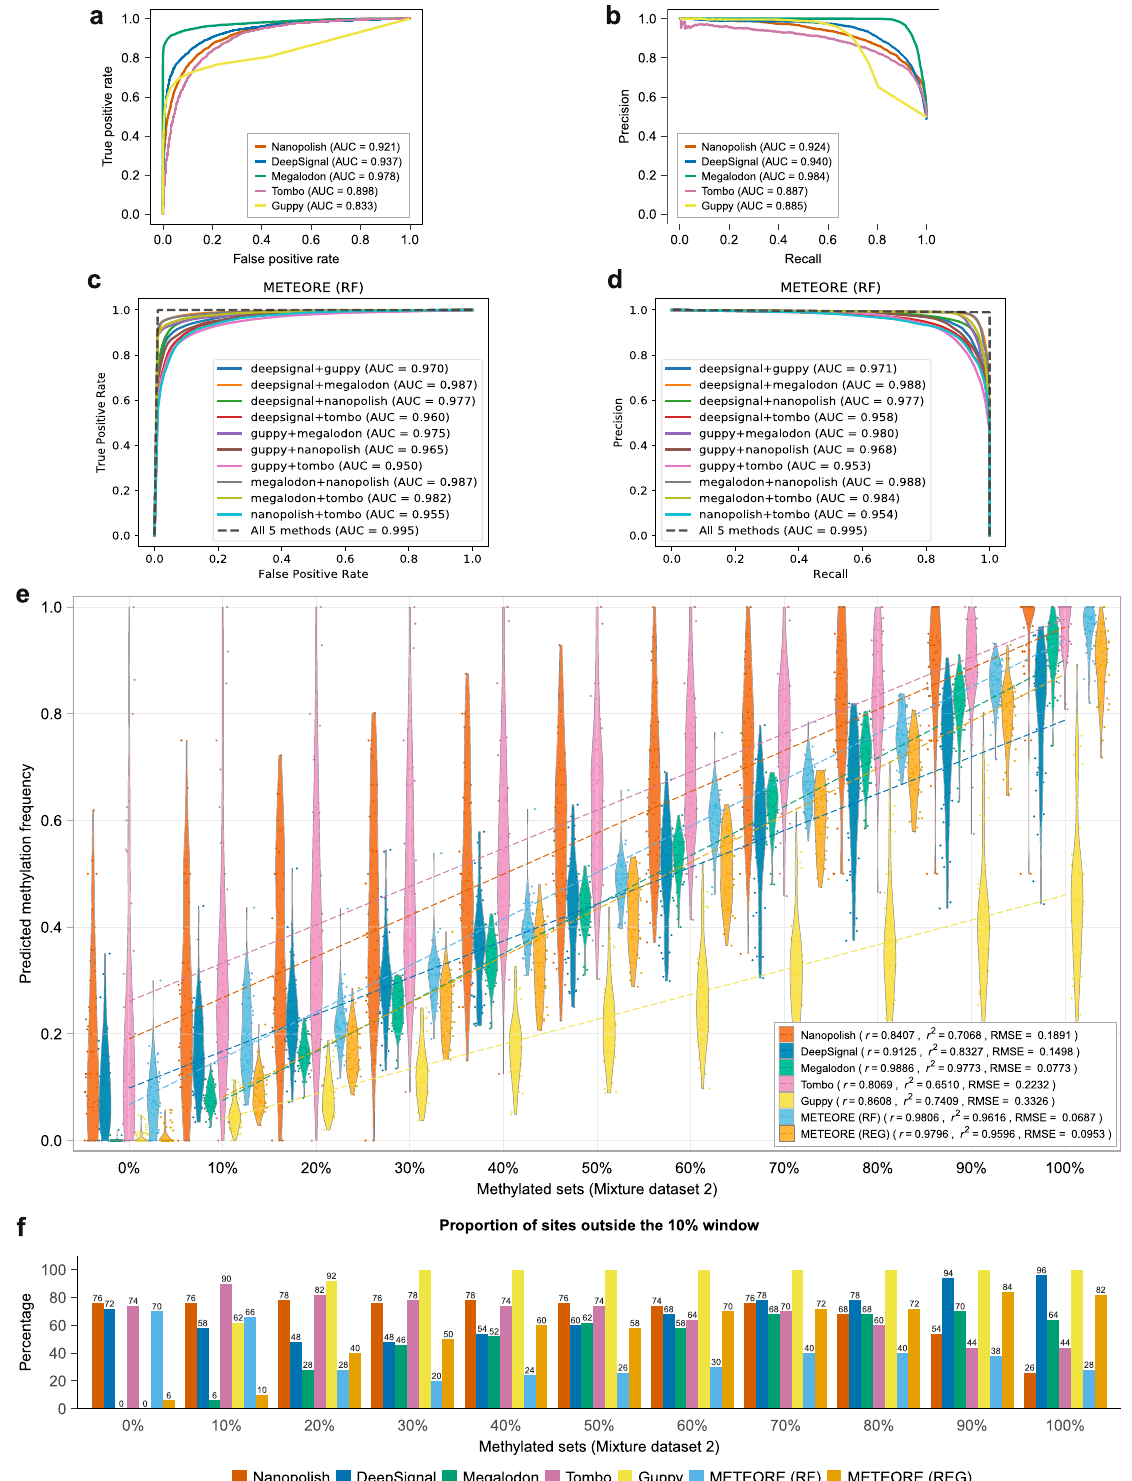
Nanopore recapitulates bisul fi te sequencing data at sites of low and high methylation . We next performed a comparison with WGBS, which is one of the most used techniques to study CpG methylation at a genome-wide scale. To achieve enough read coverage, we used the Cas9-targeted nanopore sequencing (nCATS) protocol 18 . We selected ten regions of forensic relevance to sequence the native nuclear DNA of a human lymphoblastoid